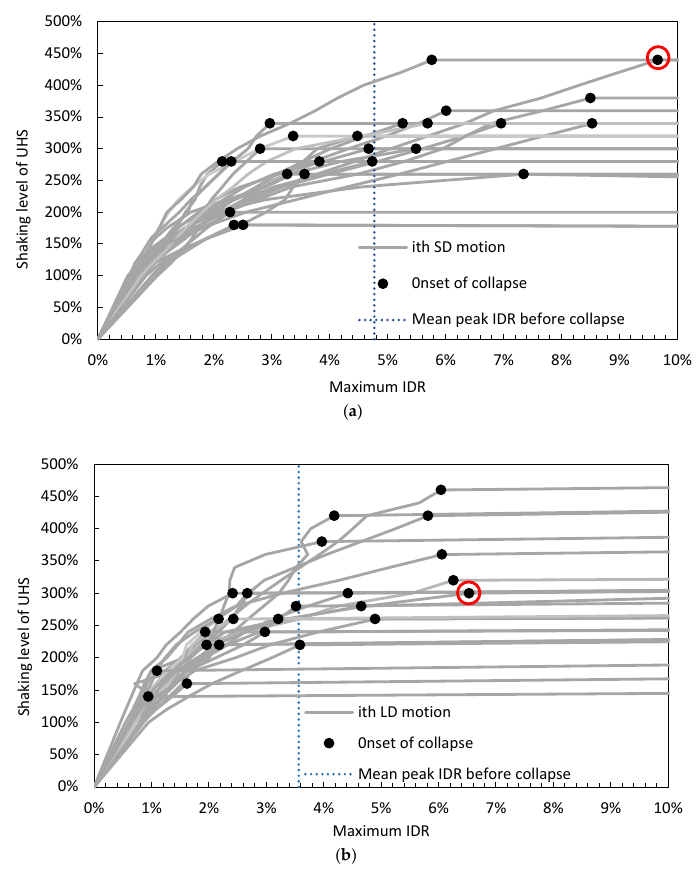
Figure 10. IDA curves of ( a ) SD and ( b ) LD motions.